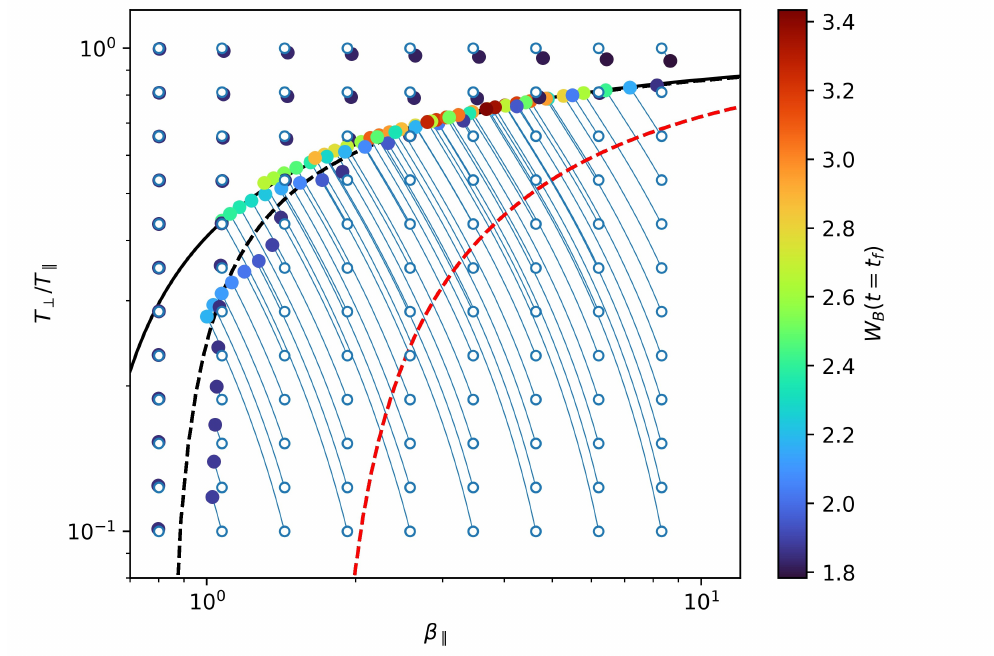
Figure 3. Quasilinear evolution of the proton β (cid:107) and anisotropy T ⊥ / T (cid:107) . Initial conditions (white cir- cles) were chosen to be evenly spaced in log space in the range 0.8 ≤ β (cid:107) ≤ 8.31 and 0.1 ≤ T ⊥ / T (cid:107) ≤ 1. The initial magnetic spectrum is defined with α = 5 with energy W B ( 0 ) = 2.0 for all cases. The colorized circles correspond to the final (stationary) state of the plasma simulations with colors depending on the final value of the magnetic energy. (Dashed lines) Contours of the maximum growth-rate γ / Ω p = 10 − 3 (black) and 10 − 1 (red) of the firehose instability, as calculated from the dispersion relation Equation (2). (Solid black line) Fitted curve T ⊥ / T (cid:107) = 1 − 0.51 ( β (cid:107) − 0.23 ) − 0.57 of the final states of the simulations starting with strongly-unstable